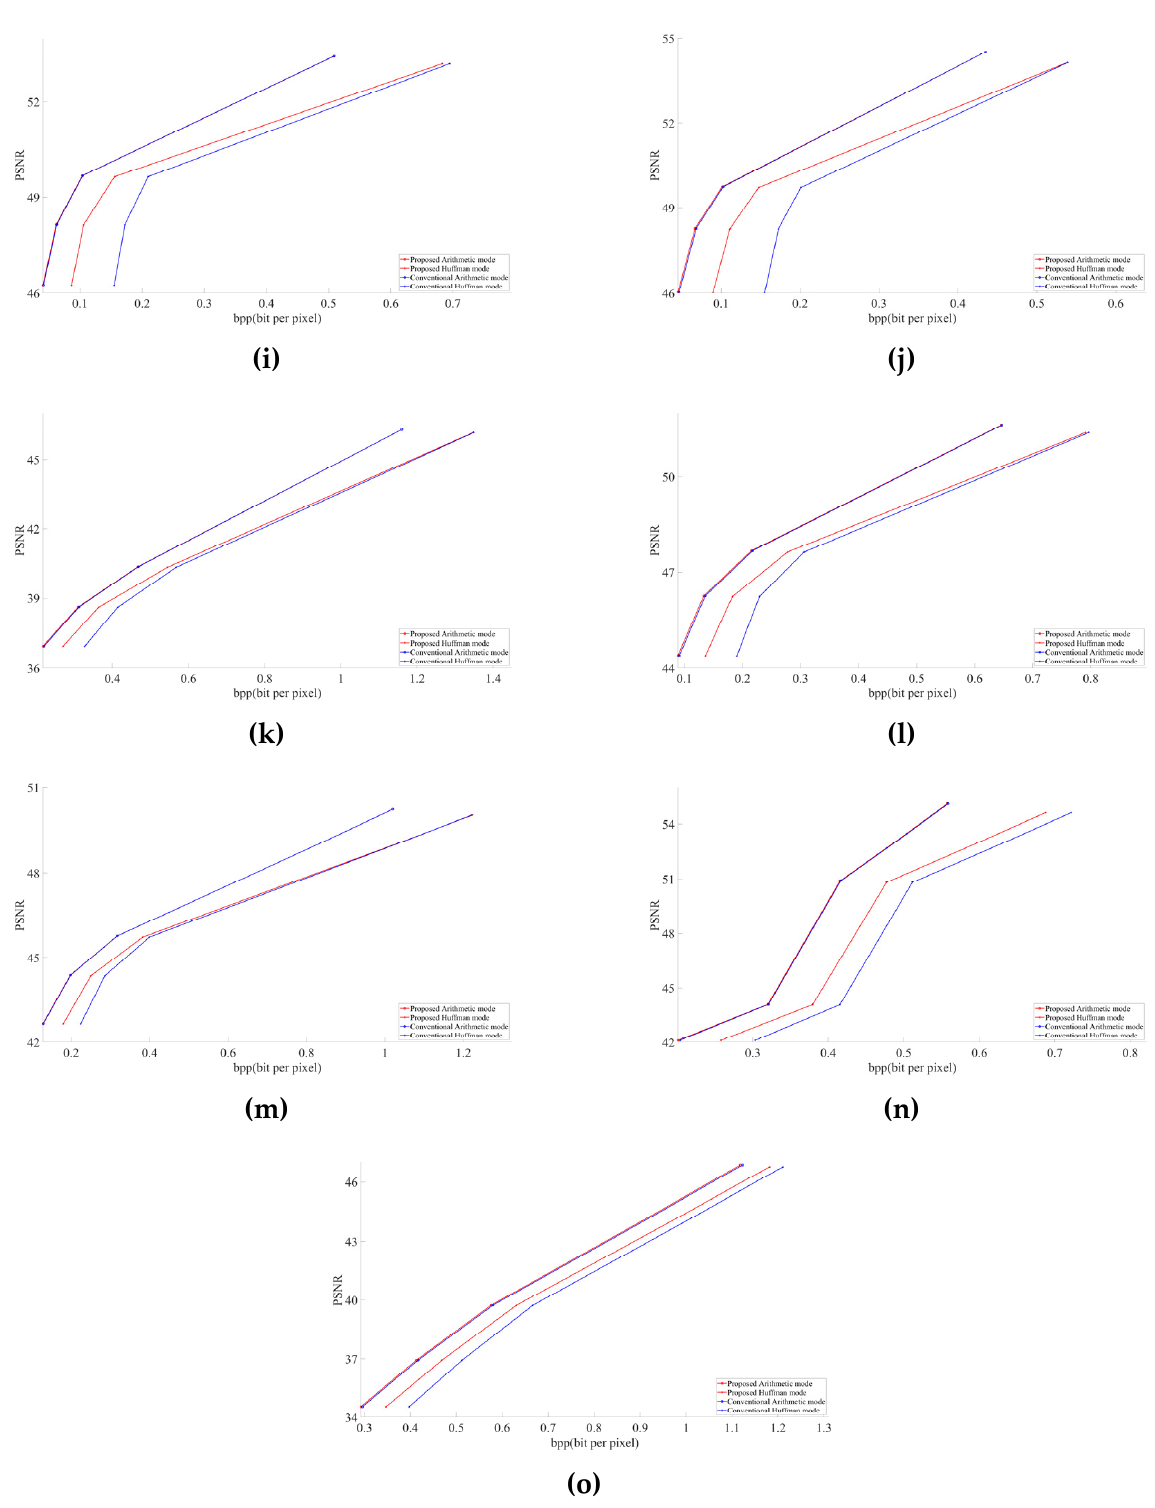
Figure 5. PSNR results of test images shown in Figure 4: ( a ) Street View, ( b ) Woman, ( c ) Night Scene ( d ) Jars, ( e ) Flowers, ( f ) Glasses, ( g ) Screenshot1, ( h ) Screenshot2, ( i ) Spoon, ( j ) Sunset, ( k ) Paris, ( l ) Ice Cream, ( m ) Air Jet, ( n ) Statue, ( o )